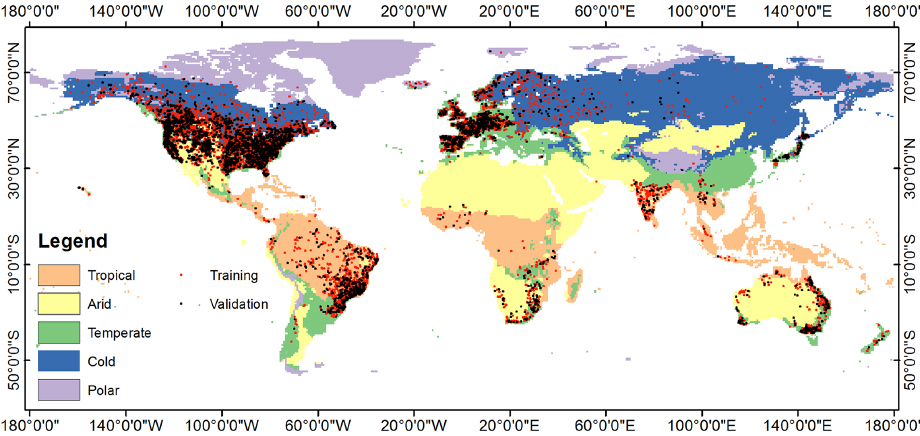
Figure 1. The distribution of discharge stations used for training and validation in this research. Table 2. Statistics and data source of the explanatory